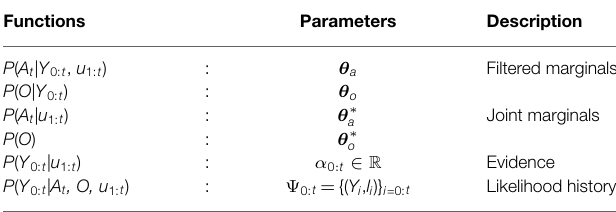
TABLE 1 | MLMF functions with associated